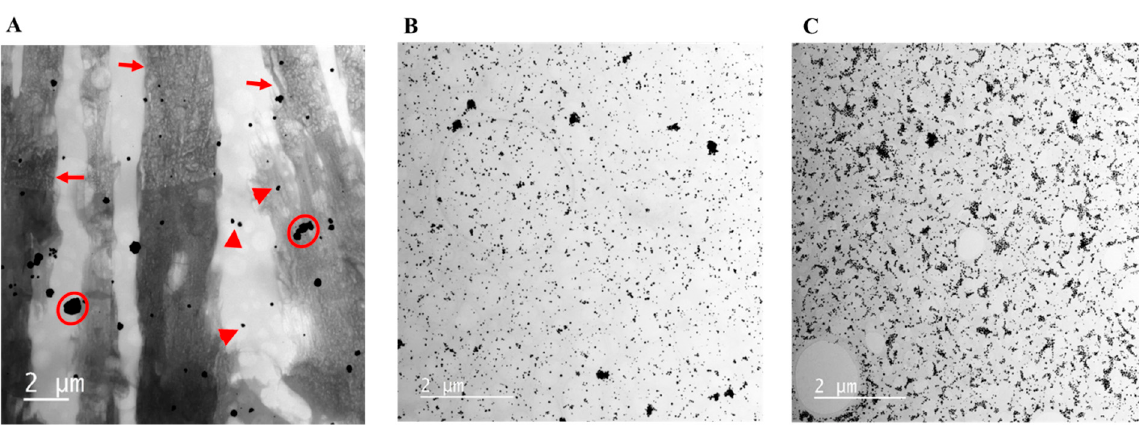
Figure 5. TEM images of nanoparticles synthesized by whole recombinant cells and soluble intracellular extracts of recombinant cells. ( A ). TEM micrograph of nanoparticles generated by whole cells. ( B ). TEM micrograph of nanoparticles synthesized by soluble extracts collected after centrifugation at 3000× g . ( C ). TEM micrographs of nanoparticles yielded by soluble extracts collected after further centrifugation at 17,000× g . Arrows indicate cellular debris; arrowheads indicate nanoparticles. Circles include large aggregates of nanoparticles.